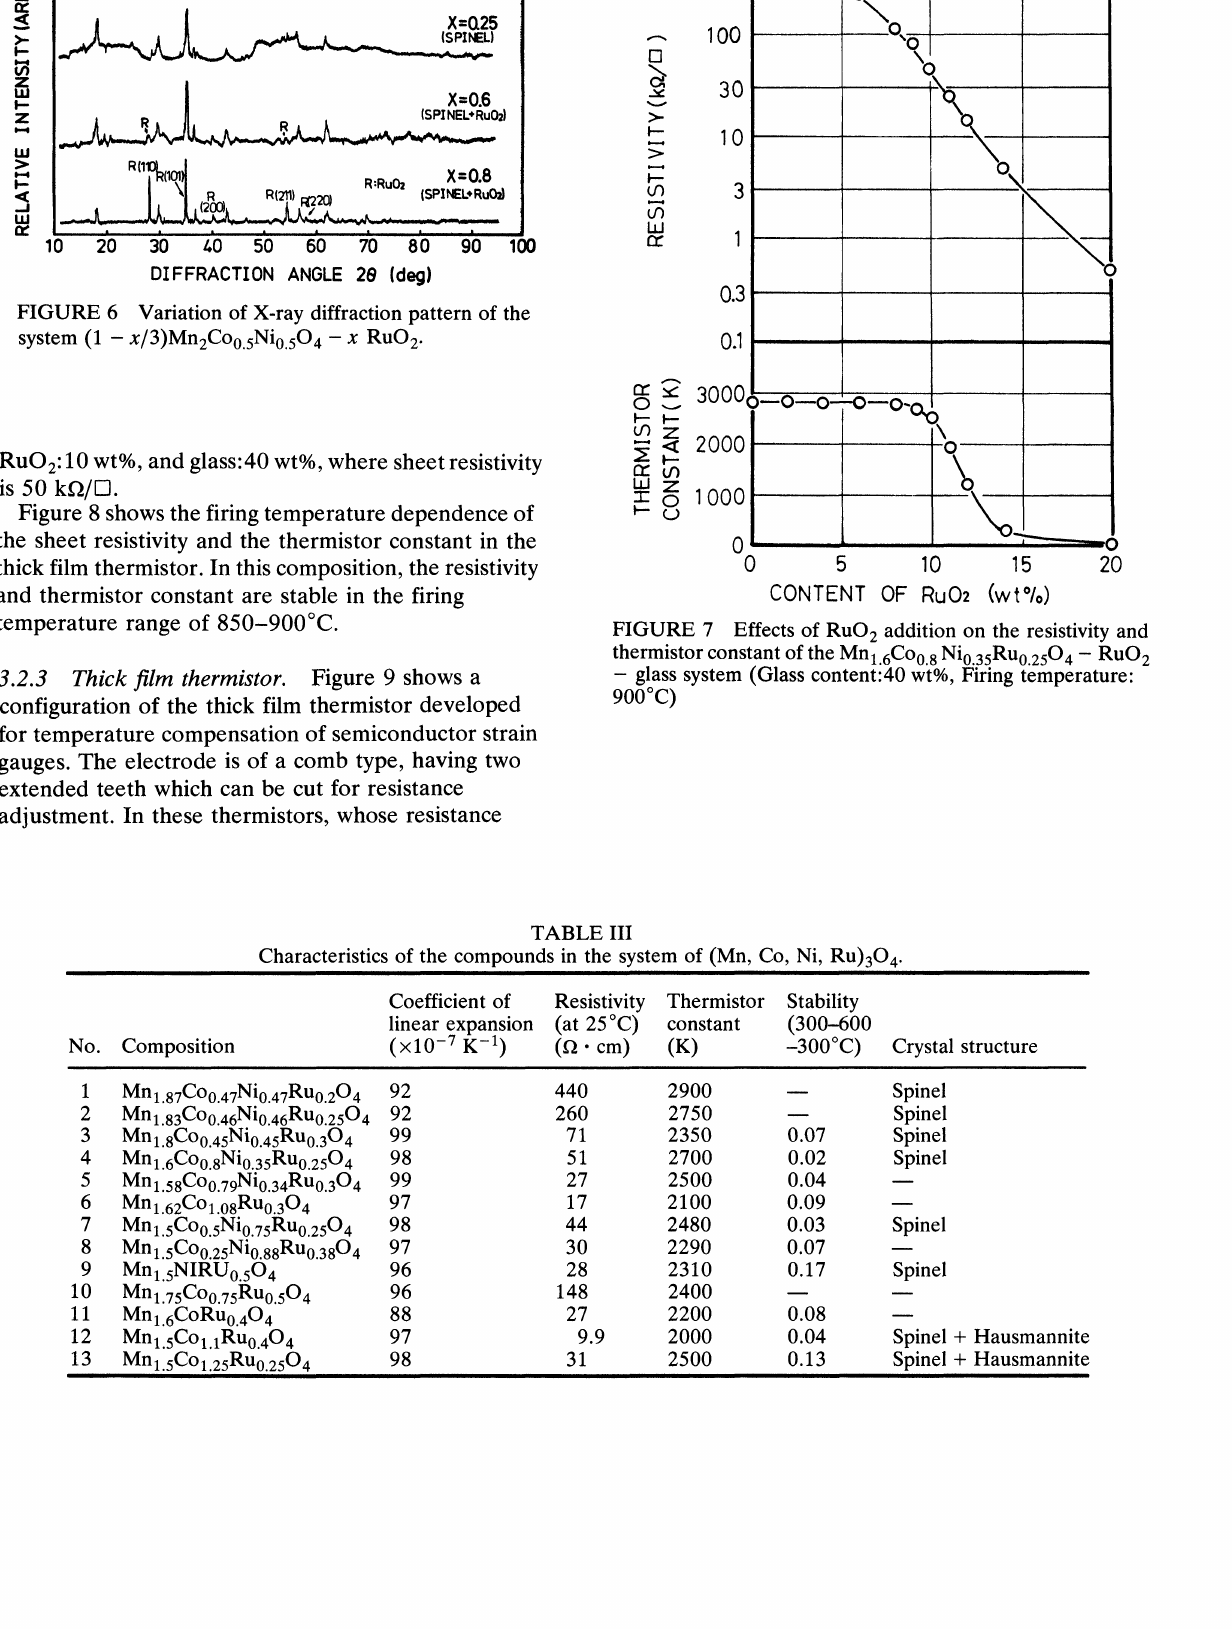
FIGURE 6 Variation of X-ray diffraction pattern of the system (1 x/3)Mn2Co0.5Ni0.504